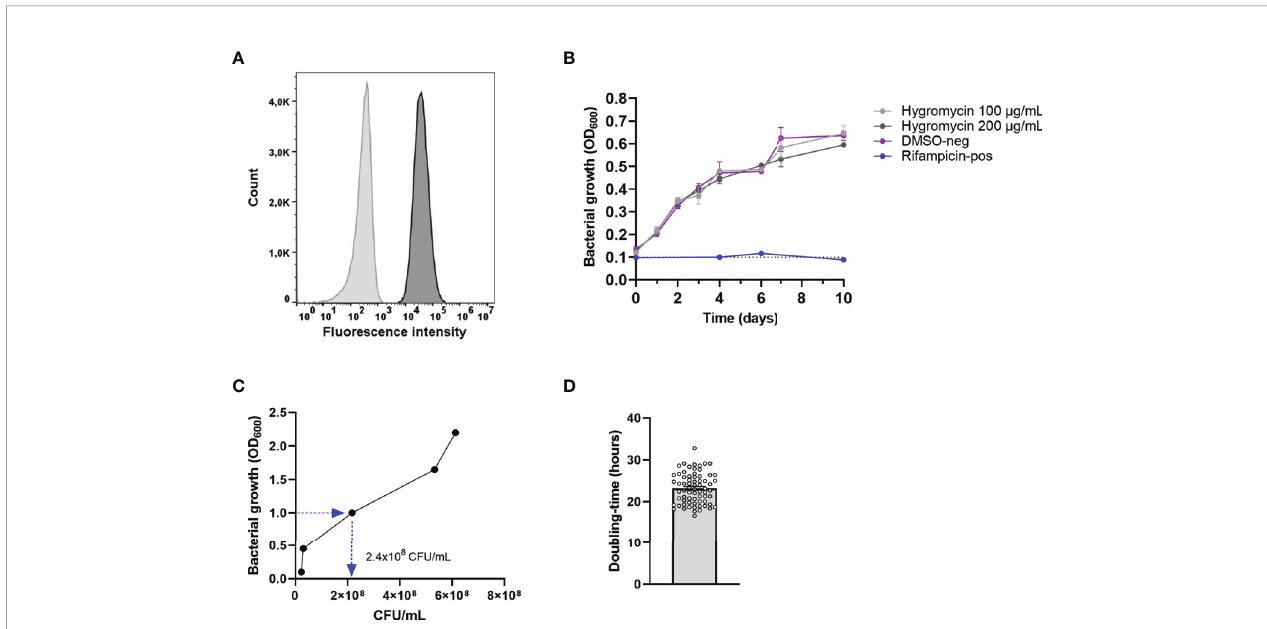
FIGURE 1 | Con fi rmation of the generation of the green- fl uorescent Mav Wasabi strain and its OD factor and doubling time. Mav was electroporated with pSMT3- Wasabi plasmid to generate a green fl uorescent Mav strain and its fl uorescence (dark gray) is presented relative to non- fl uorescent Mav (light gray) (A) . Mav Wasabi growth in the presence of hygromycin in the indicated concentrations, DMSO (negative control), or 20 m g/ml rifampicin (positive control) was monitored by absorbance measurements at 600 nm, performed in n = 3 with error bars depicting SEM between experiments (B) . Growth kinetics of Mav Wasabi was monitored by measuring OD 600 values once every 24 h, while CFU were quanti fi ed using CFU agar plate counting at the same time points. After 48 h, the bacterial density was measured to be OD 600 of 1.0 (C) . The doubling time was determined as the amount of time required for the multiple generations that occurred in the Mav Wasabi bacterial population (D) . The bar and whiskers represent mean ±